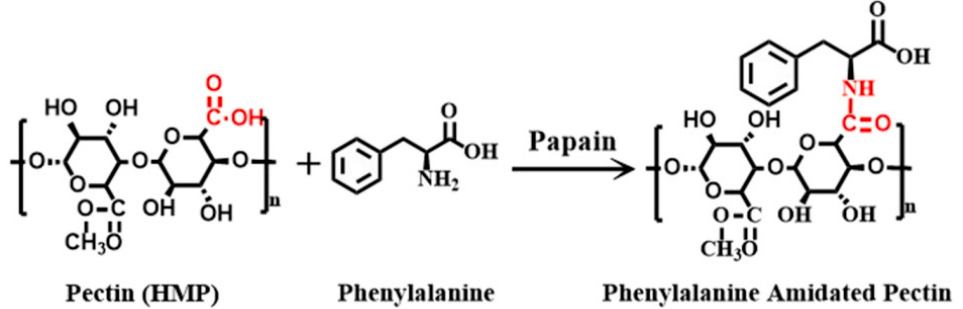
Figure 8. Scheme for the formation of phenylalanine amidated Pec. Reproduced with permission [72].